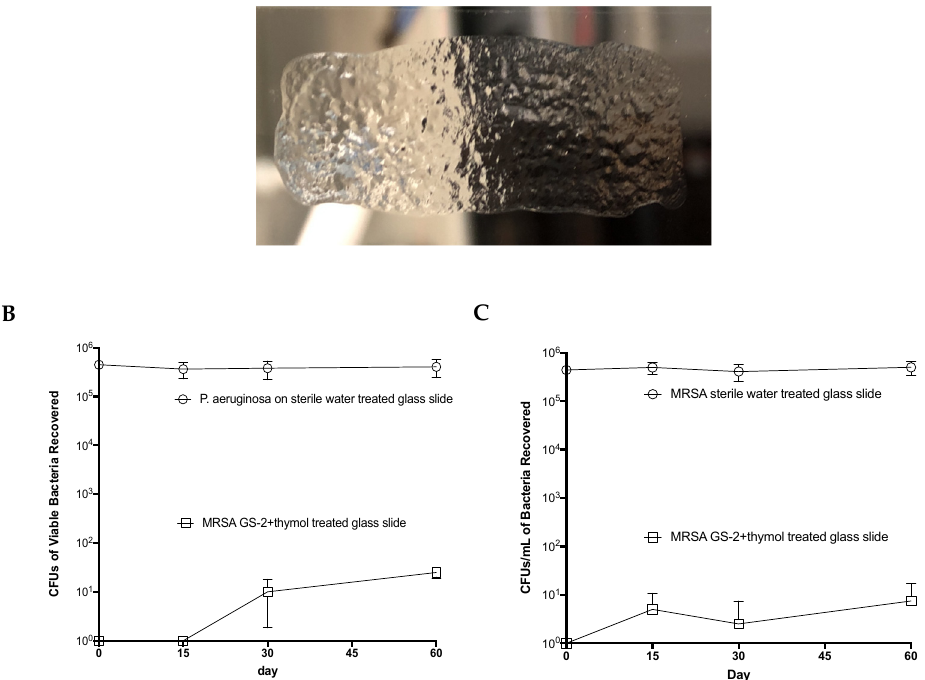
Figure 5. GS-2 with thymol maintains its antibacterial efficacy on surfaces 60 days after application. Sterile glass slides were coated with 200 μ L of GS-2 with thymol or 200 μ L of sterile water and incubated, uncovered, at 20–23 °C for up to 60 days. ( A ) Representative image of GS-2 dried on a slide. ( B , C ) After 0, 15, 30, or 60 days, slides were inoculated with 1 × 10 6 CFUs of either ( B ) MRSA or ( C ) P. aeruginosa and incubated for 60 min at room temperature. Viable bacteria were then extracted from the slides, serially diluted, and plated onto 5% SBA plates, and colonies were counted the following day. ( n = 4; mean ± SD).